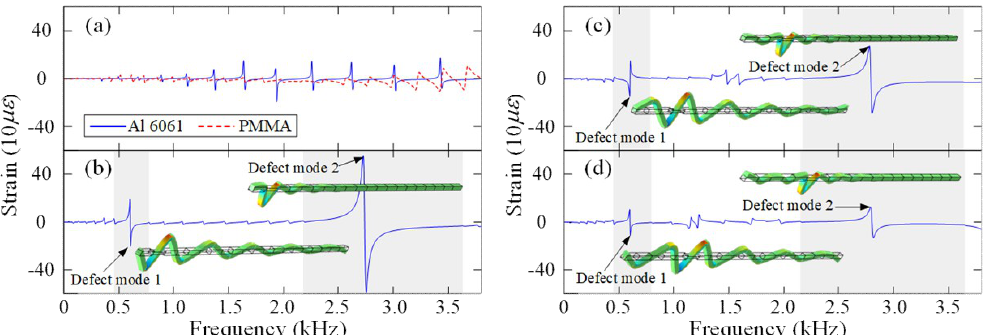
Figure 3. Strain responses in the ( a ): homogeneous beam with a mismatched segment, ( b ): EHPC1 beam, ( c ): EHPC2 beam, and ( d ): EHPC3 beam with the dynamic displacement vibration shapes and the strain field distribution at the defect modes (color online).